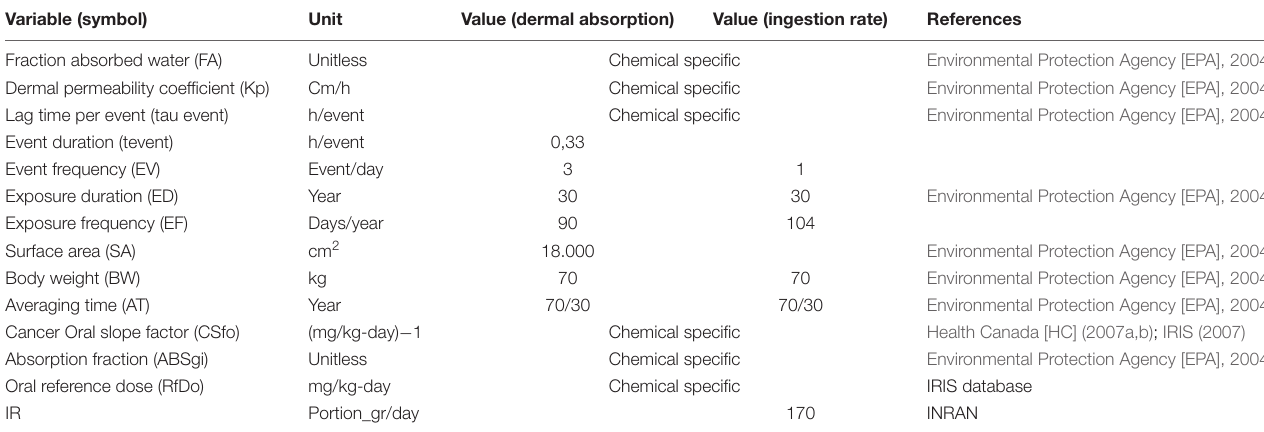
TABLE 1 | Variables used for risks